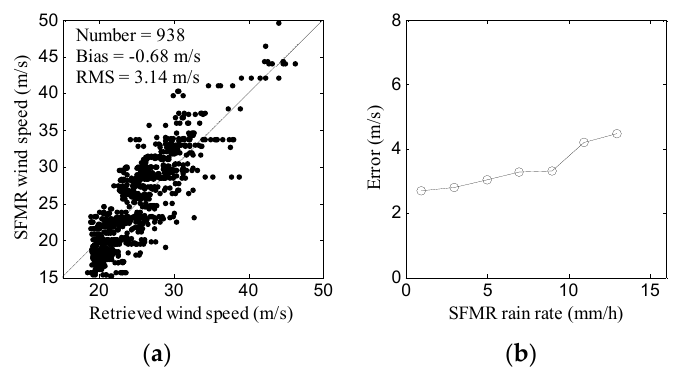
Figure 9. ( a ) The comparison between SFMR wind speeds and the retrieved wind speeds with our new method; ( b ) Errors of the retrieved wind speeds versus SFMR rain rate.